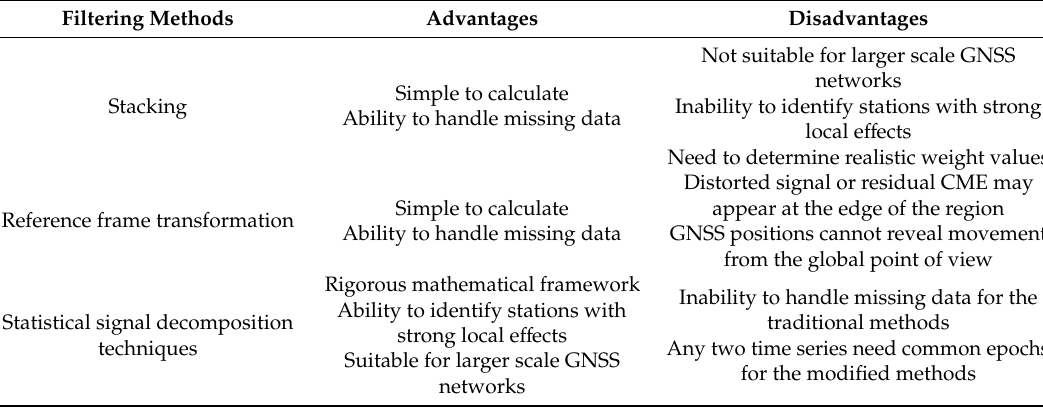
Table 1. Advantages and disadvantages of various mathematical methods used so far to filter common mode error